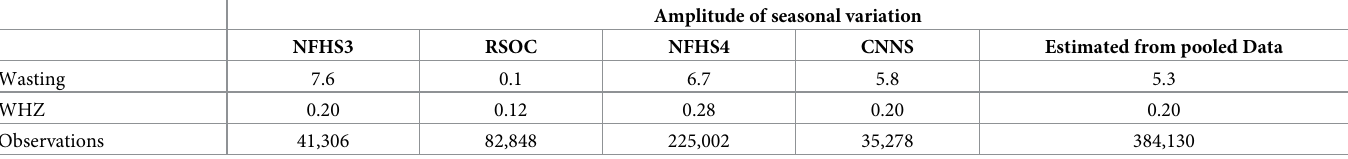
Table 3. Amplitude of seasonal variation of prevalence of wasting and WHZ by